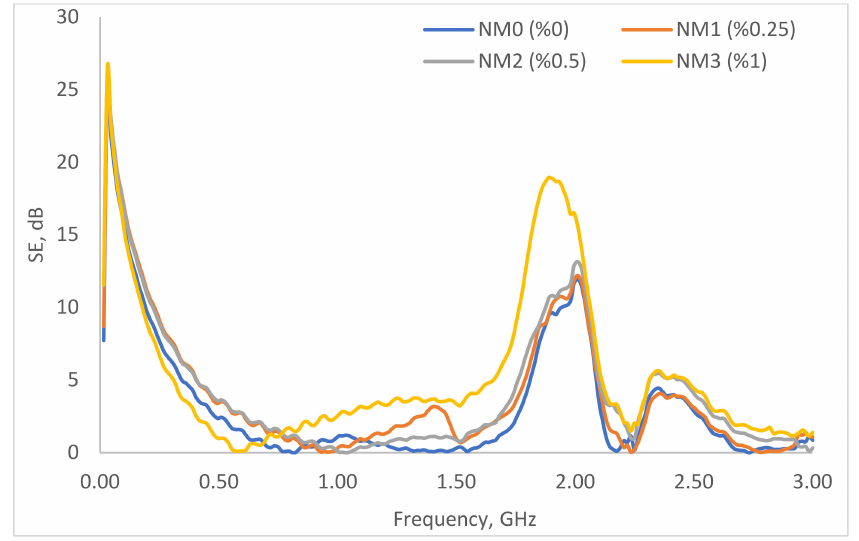
Figure 10. Electromagnetic (EM).